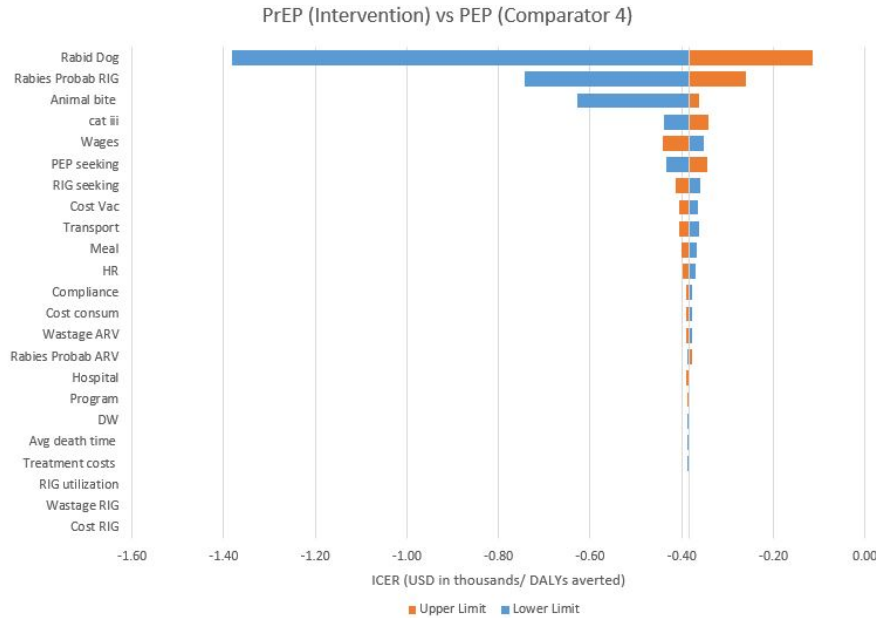
Figure 2. One − way sensitivity CE analysis: PrEP (I) vs. C4. Animal bite—Animal bite incidence; Avg death time—Average time a person lives after the onset of rabies; Cat